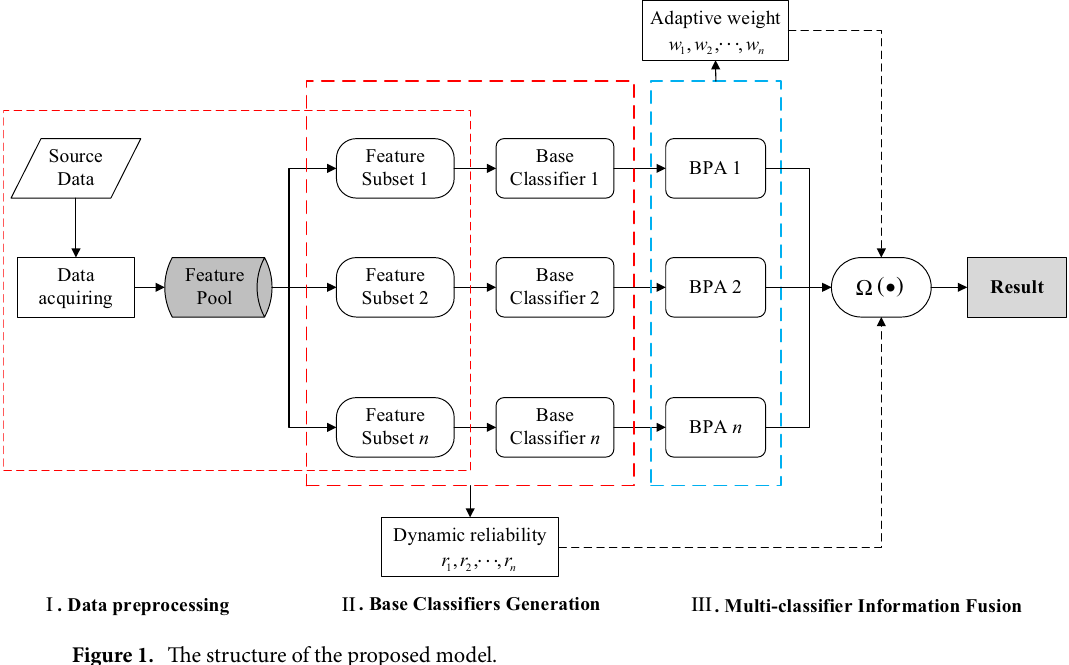
Figure 1. The structure of the proposed